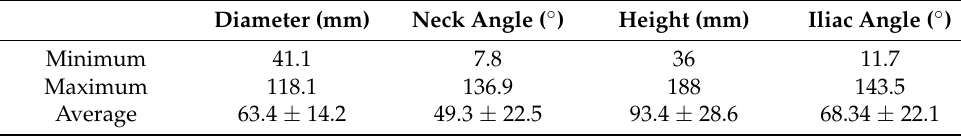
Table 2. Abdominal aortic aneurysm AAA geometrical